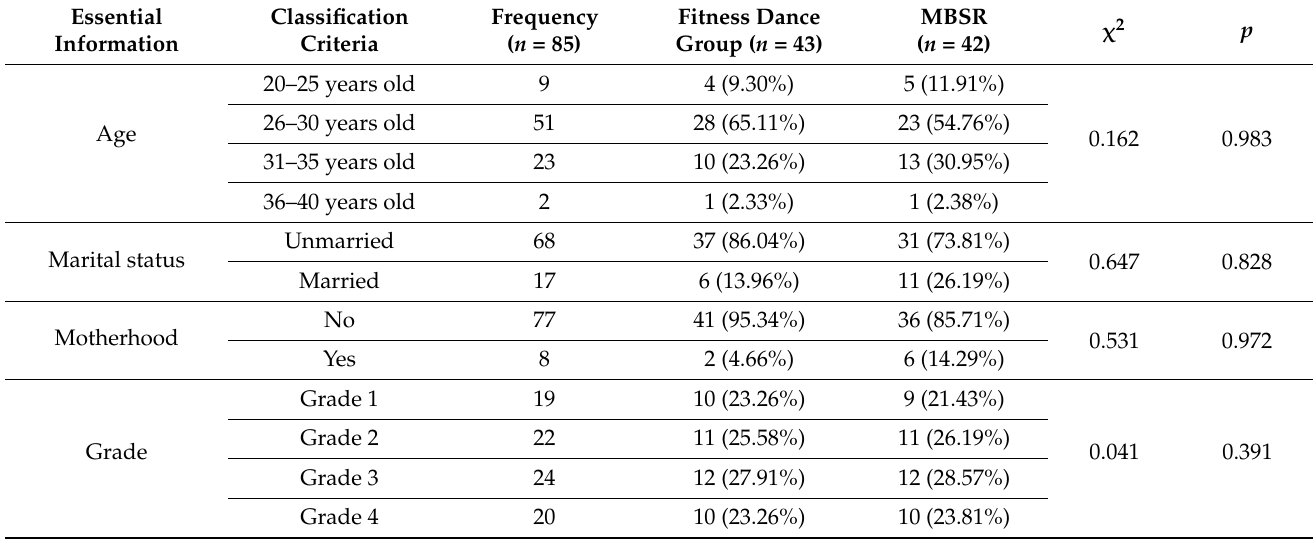
Table 1. Comparison of demographic data balance between two groups of female Ph.D. candi- dates ( n =